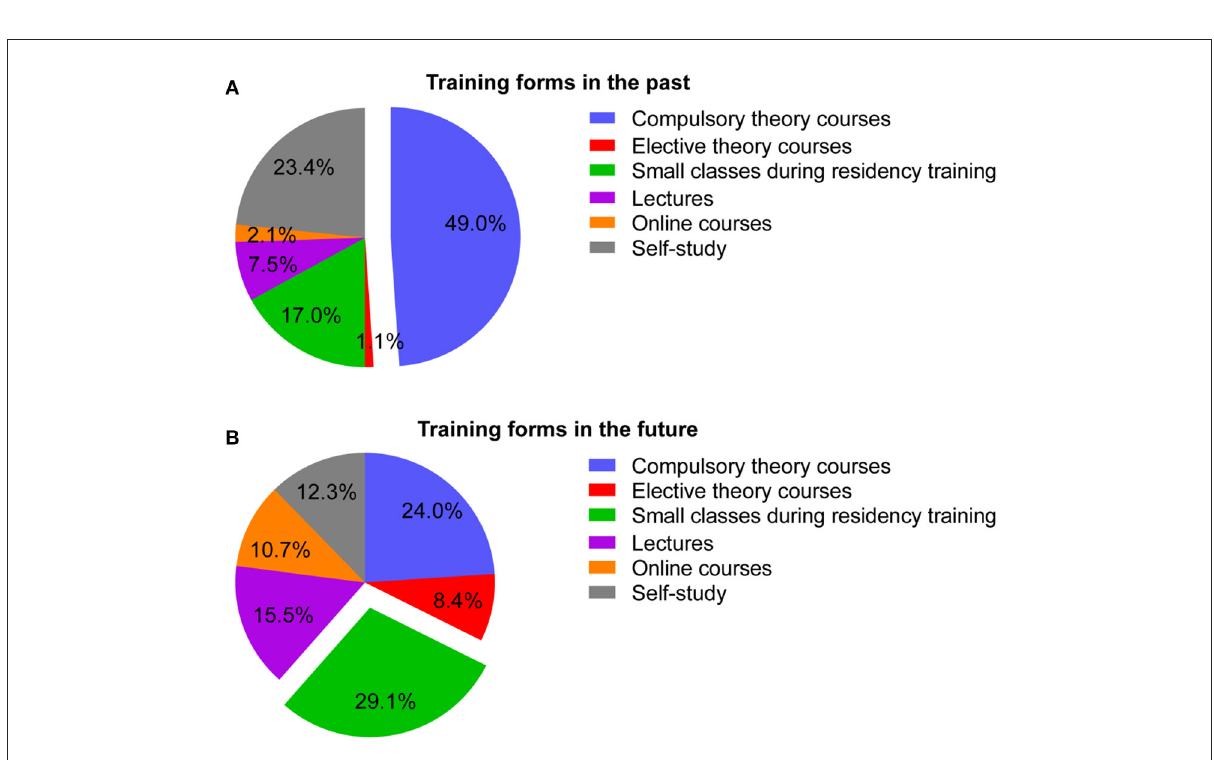
FIGURE3 Composition of the form of the sleep breathing disorder course received in the past (A) and chosen in the future (B)